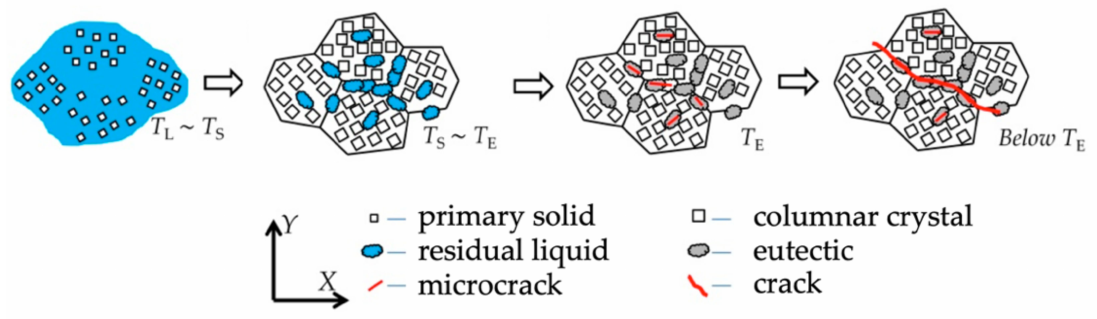
Figure 3. Schematic diagram of the crystallisation cracking mechanism.